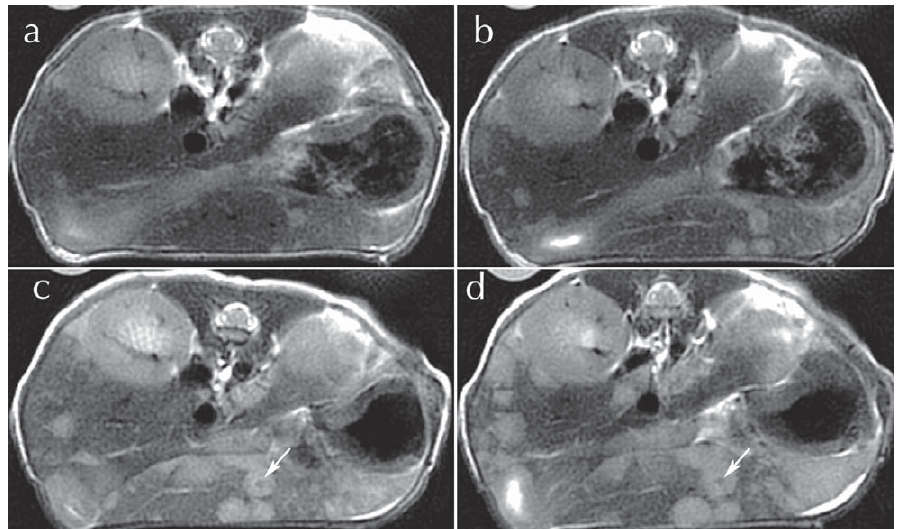
Fig. 8. PROPELLER images of a free-breathing mouse follow the evolution of metastatic colon cancer in the liver at (a) day 21; (b) day 24; (c) day 28; (d) day 31 post-inoculation. Lesions measuring <200 (cid:1) m seen in day 21 can be seen in the 1mm slices out to the point where the necrotic core begins to form (arrows). Courtesy Dr. Prachi